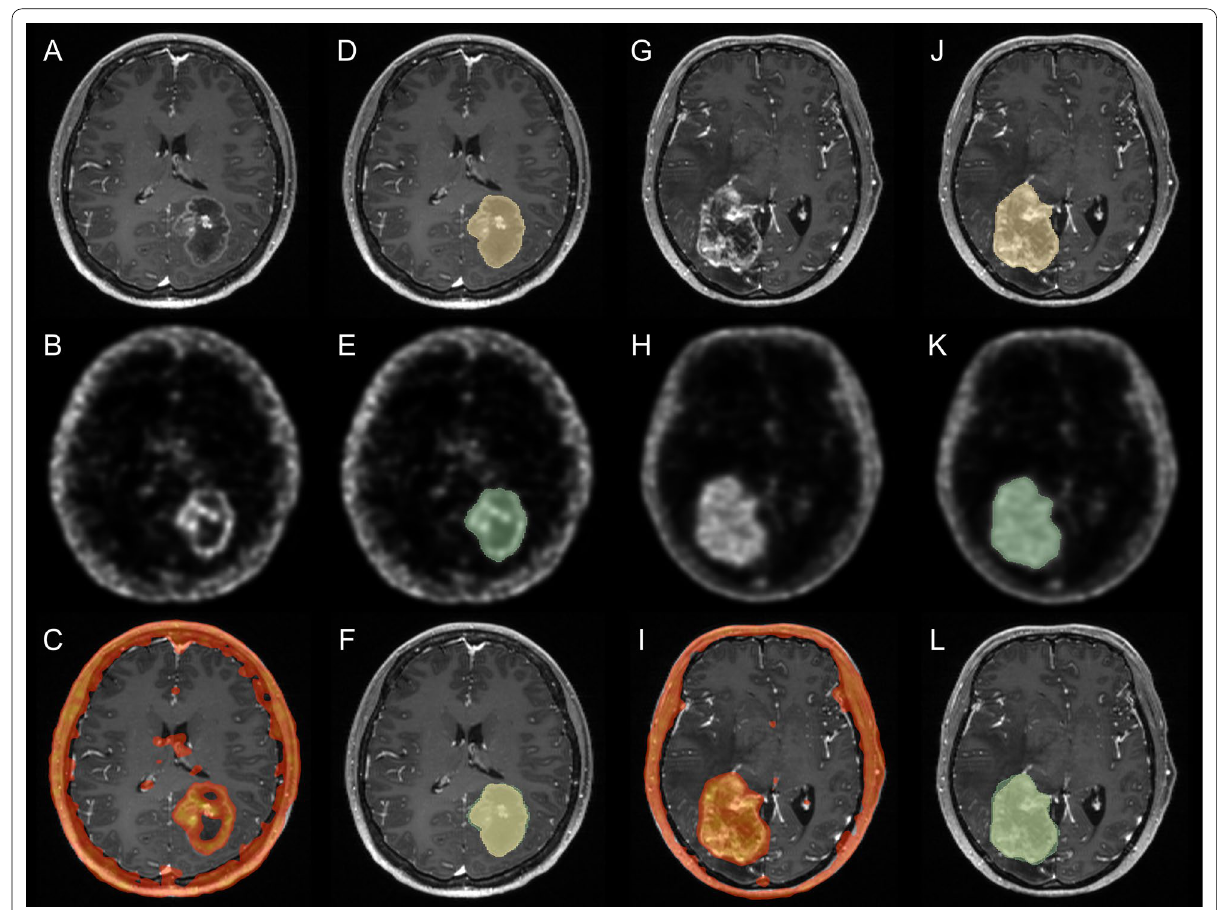
Fig. 2 Examples of MRI and FBY PET images in circumscribed tumors. A left temporal-occipital metastatic breast cancer (HER2 positive, ER and PR negative) revealed significant contrast enhancement ( A ) and FBY activity ( B ), with better adhesion between the two regions ( C ). Semiautomated segmentation based on MRI ( D ) and FBY PET ( E ) was performed, and minimum FBY activity beyond MRI contrast enhancement was noted ( F ). Similarly, a right temporal-occipital metastatic breast cancer (HER2 negative, ER and PR positive) displayed contrast enhancement ( G ) and FBY uptake of the whole tumor region ( H ), both of which presented an explicit tumor extent ( I ). The semiautomated segmentations ( J , K ) were also largely equivalent ( L ), which may be due to the clear boundary of circumscribed